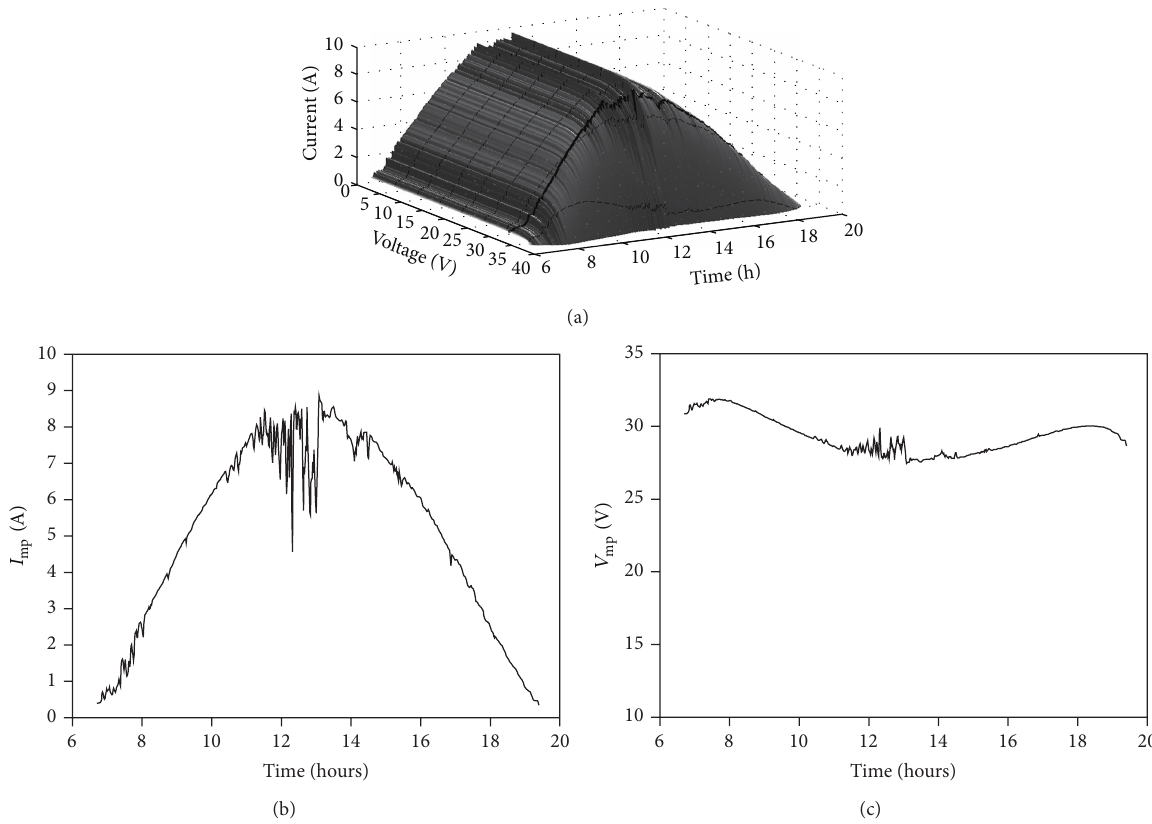
Figure 8: Evolution of the I - V curve of YL280C-30b monocrystalline solar panel according to ambient conditions, that is, sun irradiance and panel temperature levels, on May 14, 1971 (a), at the Goddard Space Flight Center (GSFC). Evolution of current (b) and voltage (c) at maximum power point (MPP).